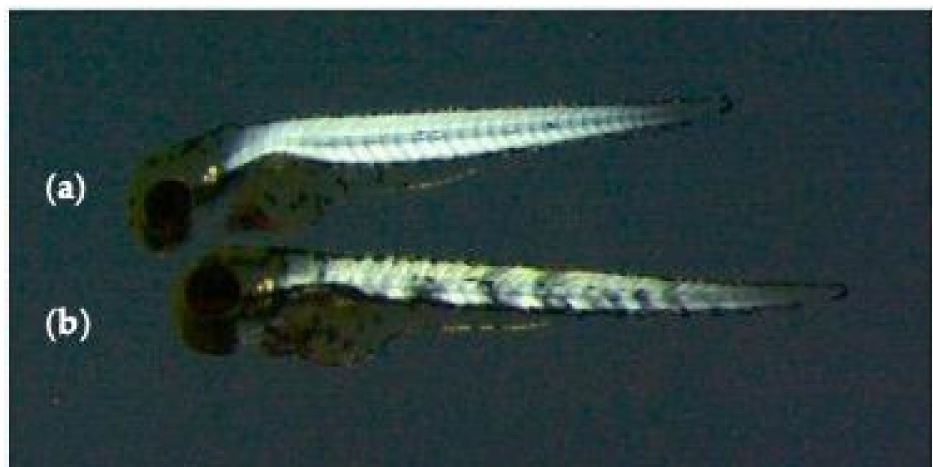
Figure 1. Birefringence of non-dystrophic ( a ) and dystrophic ( b )